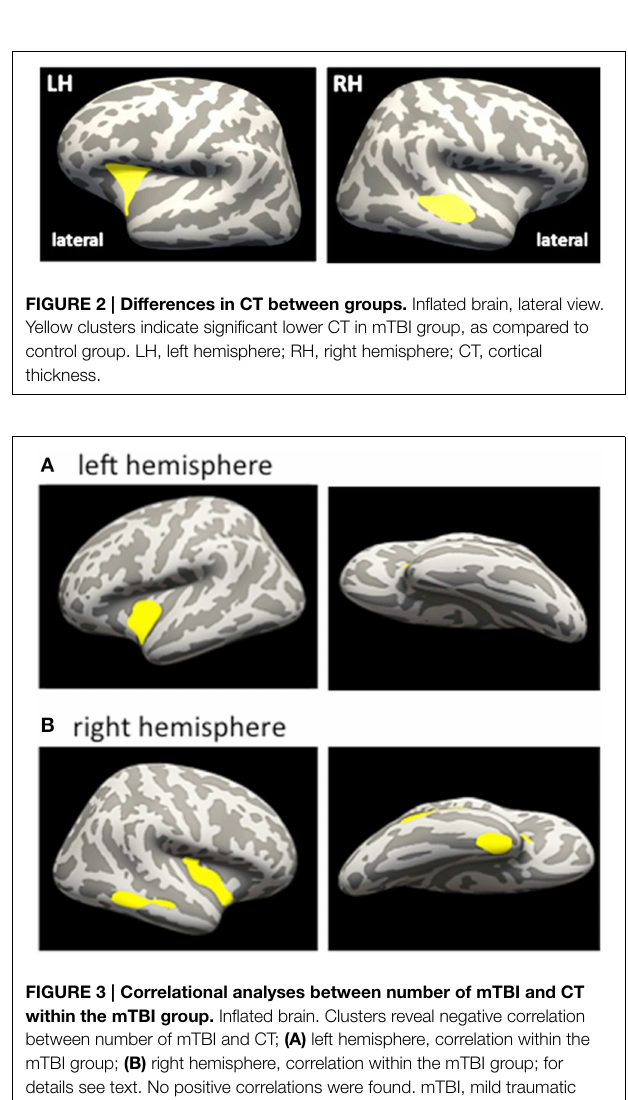
(insula: 2061 vertices, 753 mm 2 , MNI-coordinates: − 29.0, 15.5, 9.5, cluster-wise p < 0 . 01, maximum t = 3 . 376), indicating